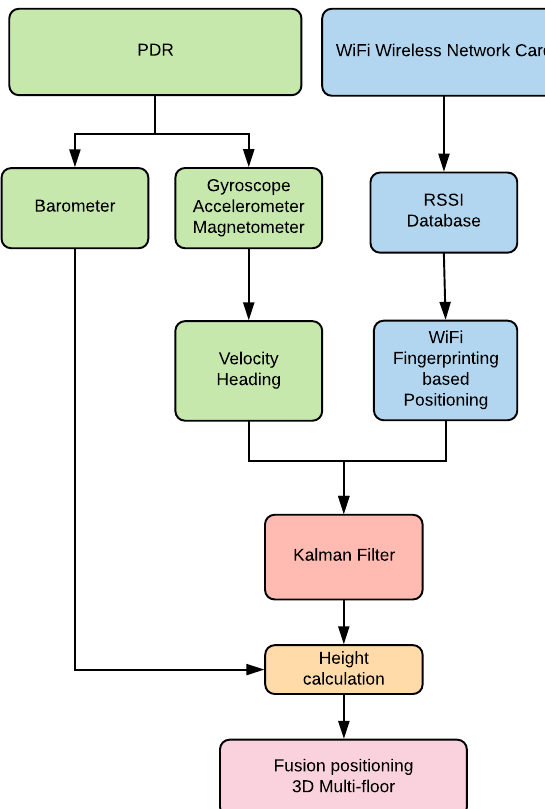
Figure 1. WIFI/PDR integrated positioning system